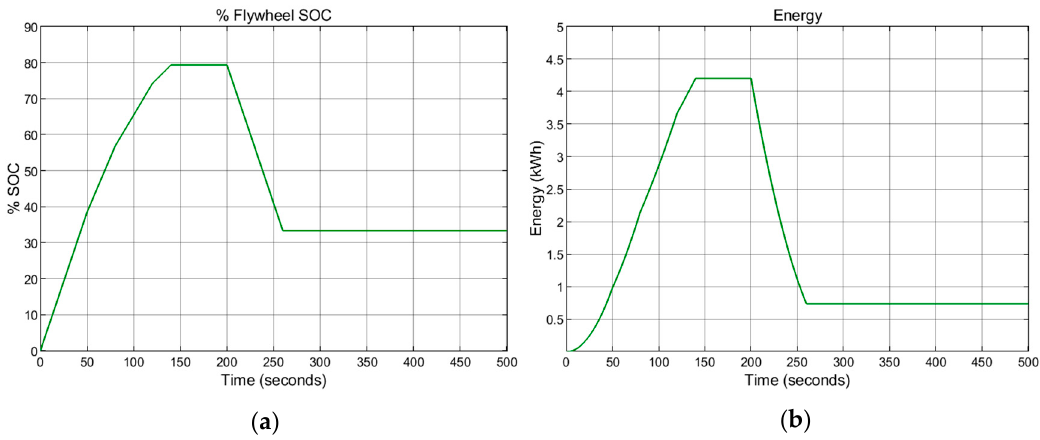
Figure 11. ( a ) % SoC of the flywheel at different torque; ( b ) Energy stored in the flywheel at different times.